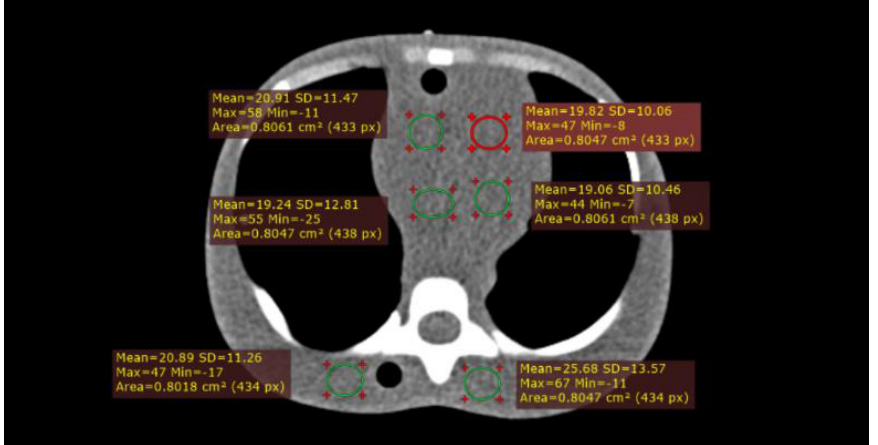
Figure 2. Example of objective image quality analysis of CT number (mean), image noise (SD), SNR, and CNR by putting the region of interest (ROI) in the lungs and soft tissue field.